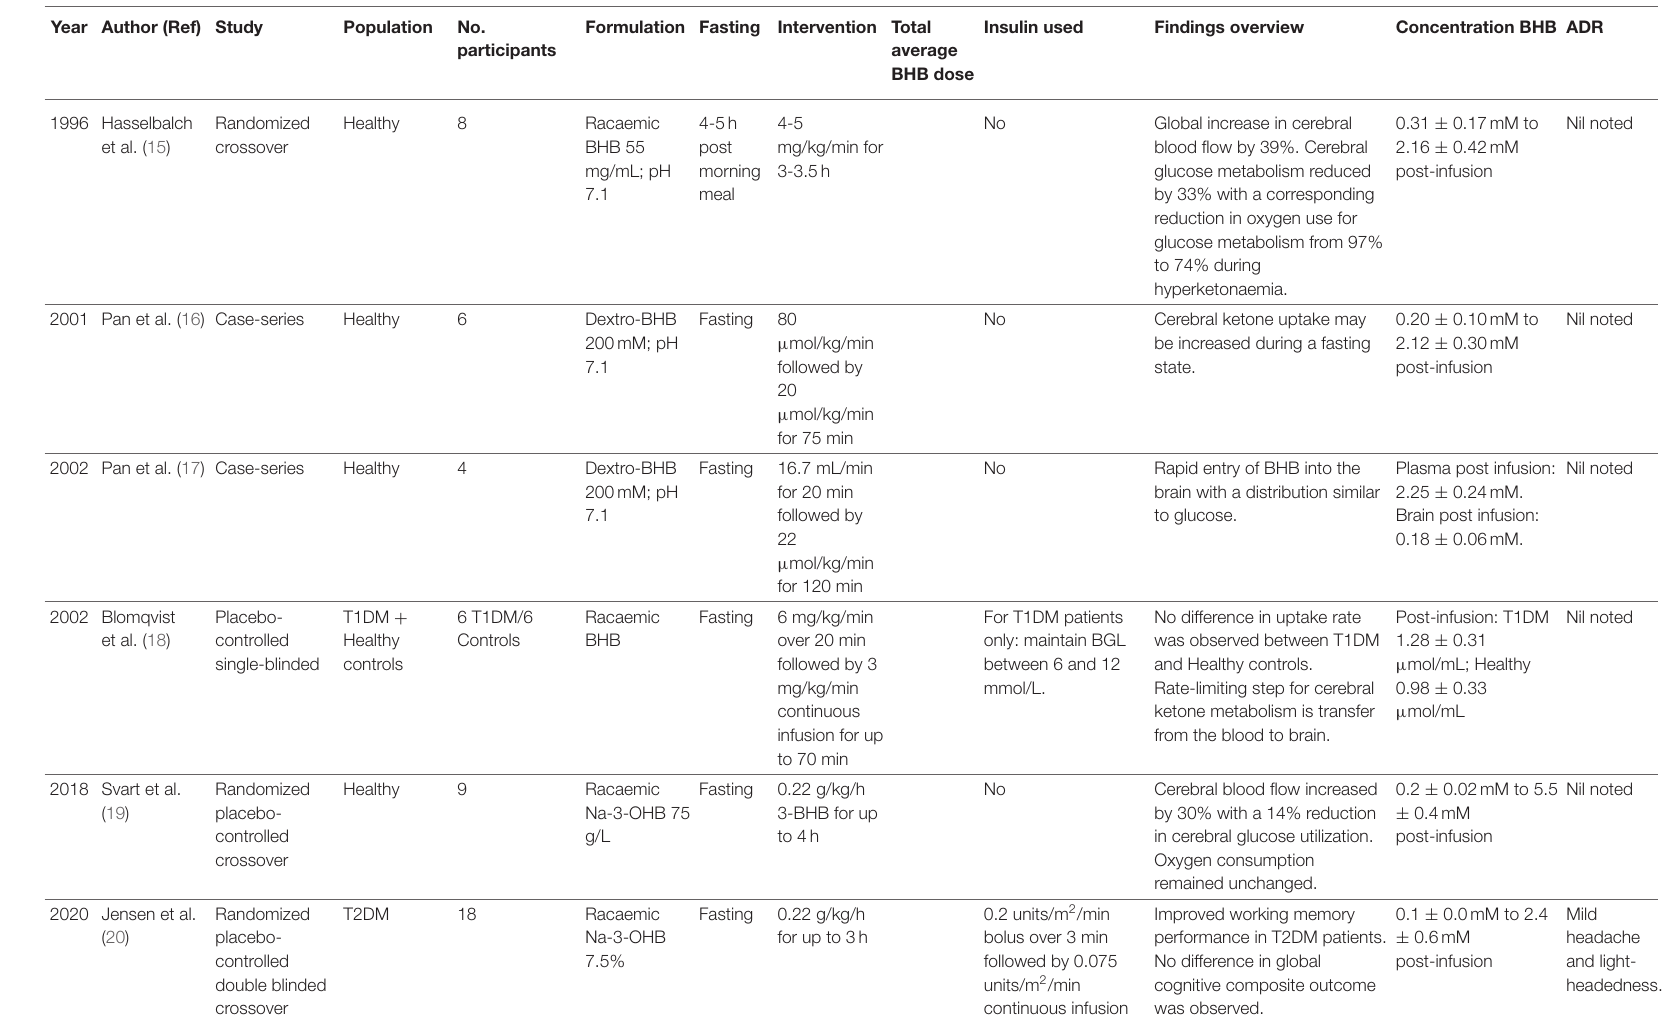
TABLE 2 | Ketone studies investigating central nervous system